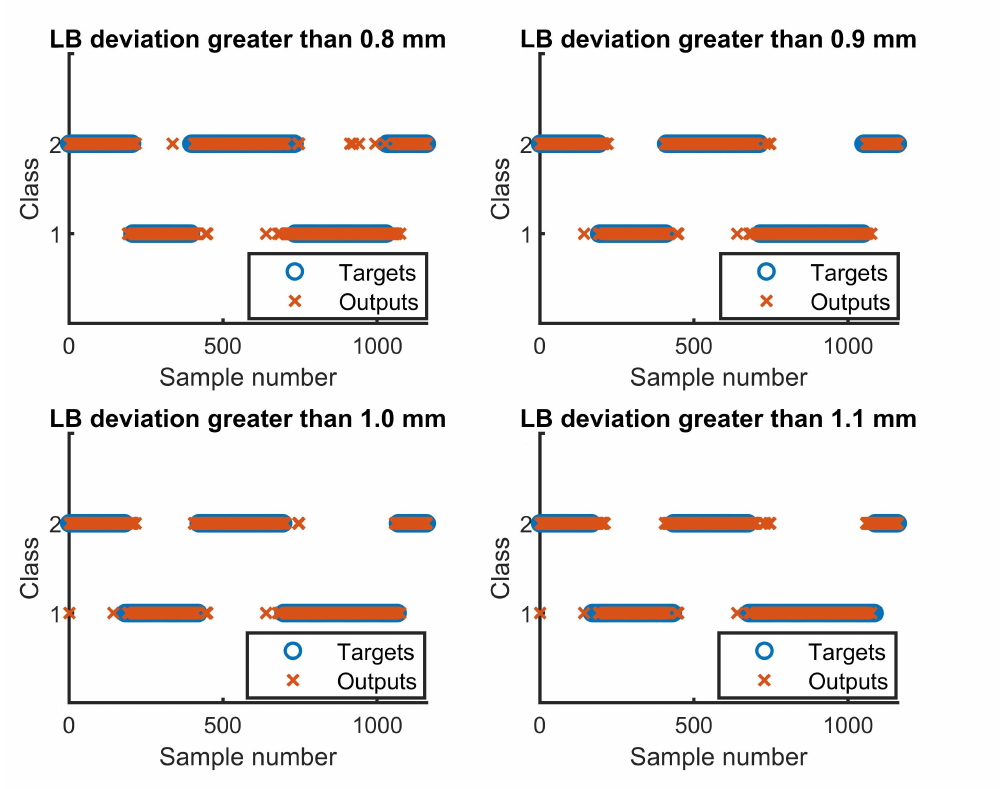
Figure 6. Outputs and targets for detecting LB deviations larger than 0.8 mm, 0.9 mm, 1 mm and 1.1